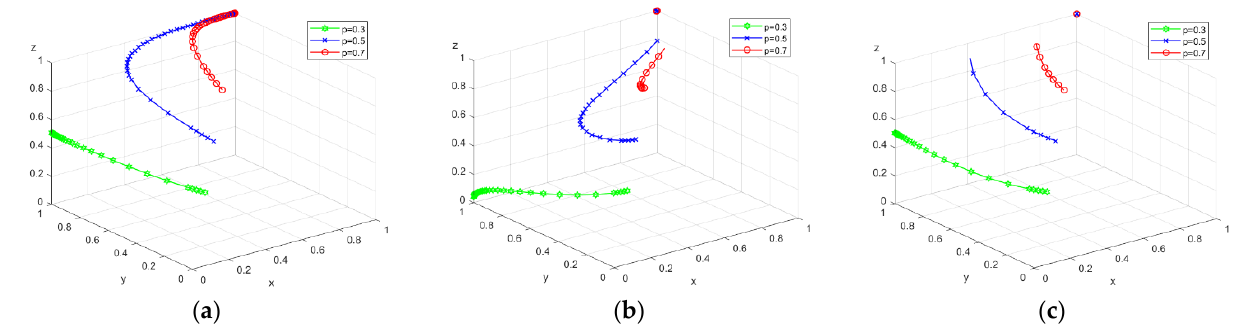
Figure 2. Strategy trajectories of the three game subjects in the 3 emotional states of the miner with different initial participation ratios. ( a ) 𝑟 1 = 𝑟 2 = 𝑟 3 = 1 ; ( b ) 𝑟 3 < 1 , 𝑟 1 = 𝑟 2 = 1 ; ( c ) 𝑟 3 > 1 , 𝑟 1 = 𝑟 2 = 1 .